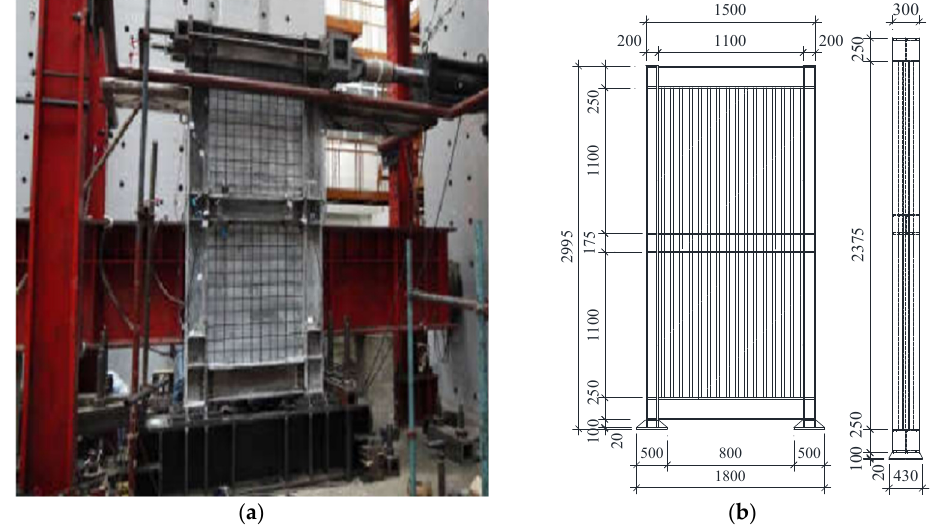
Figure 5. Test specimen S-4 [46]: ( a ) Test site equipment; ( b ) Dimensions of the test specimen.